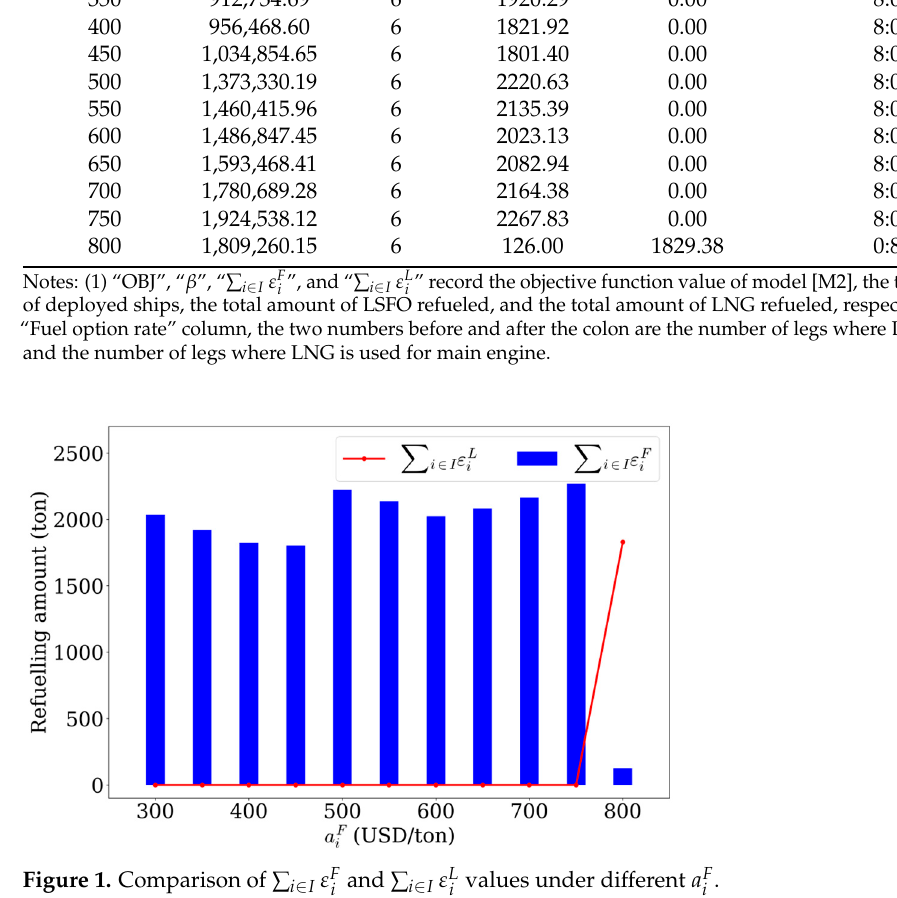
and ∑ i ∈ I ε L values under different a F i i